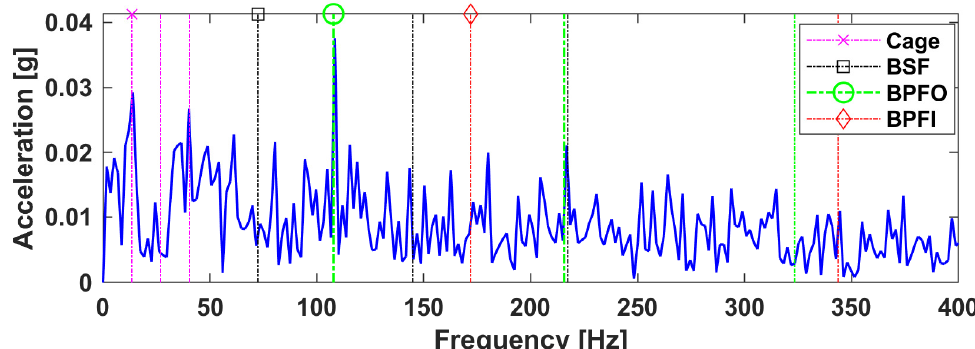
Figure 15. The amplitude spectrum attained by the LRANTD method in Case A (Proposed method).